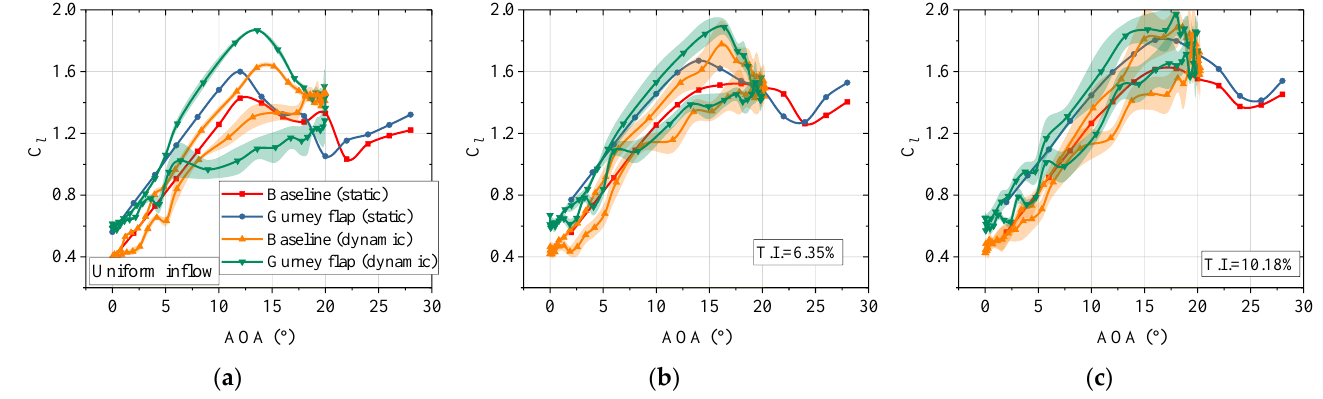
Figure 7. Comparison of lift coefficients for A = 10, α mean = 10 and K = 0.0167. ( a ) uniform inflow; ( b ) T.I. of 6.35%; ( c ) T.I. of 10.18%.